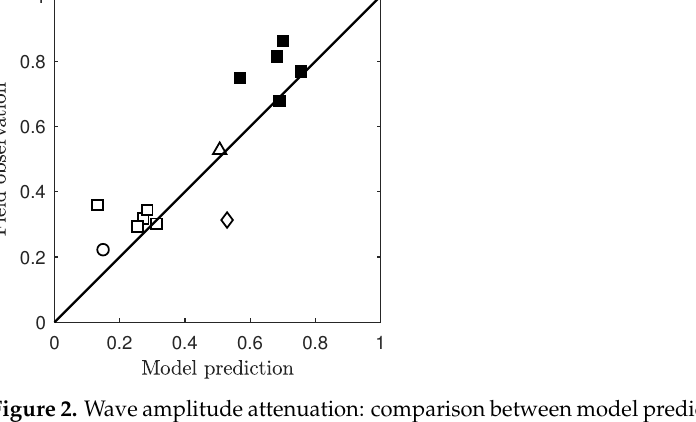
Figure 2. Wave amplitude attenuation: comparison between model predictions and field observations. (cid:52) : field study reported by Tubman and Suhayda [2]; (cid:3) and (cid:4) : Wells and Coleman [4]; (cid:5) : Mathew [5]; ◦ : Rogers and Holland [6]. See Table 1 for the model